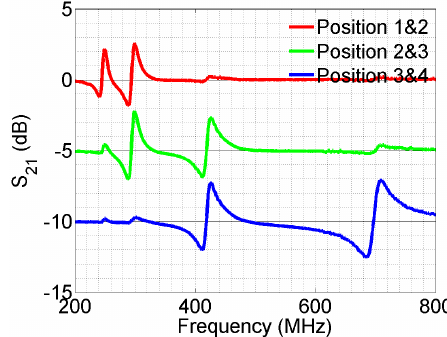
Figure 12. The transmission spectrum with the target at two positions at the same time, normalized by the unloaded case. Additional curves are moved down 5 dB on the y-axis each time to separate the overlapping region for better